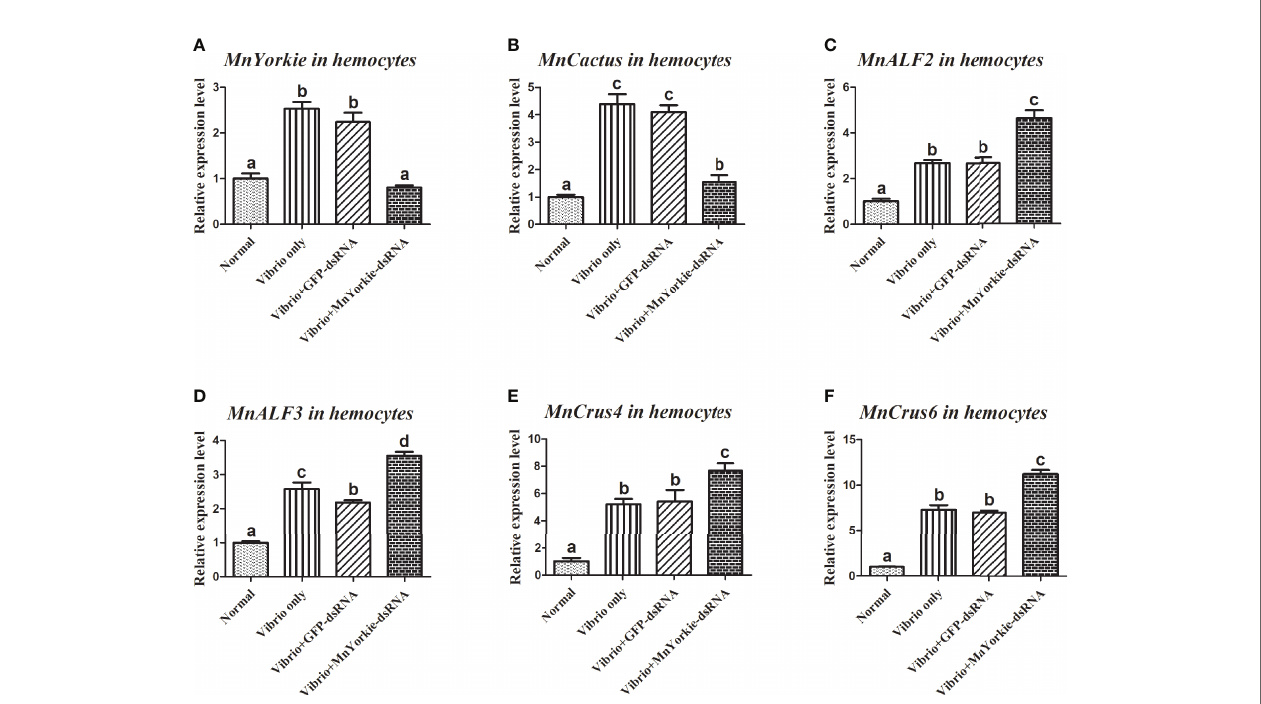
FIGURE 9 | Analysis of MnCactus and four immune-related genes expression levels after MnYorkie RNAi. (A) Ef fi ciency of RNAi detected by RT-qPCR in hemocytes at 36 h post of MnYorkie -dsRNA and V. parahaemolyticus injection. The mRNA expression levels of MnCactus (B) , MnALF2 (C) , MnALF3 (D) , MnCrus4 (E) , MnCrus6 (F) were detected by RT-qPCR at 24 h injection of V. parahaemolyticus post MnYorkie RNAi. Signi fi cance differences were compared between the normal group to other treated groups at the same time point. Signi fi cant differences were marked with different letters (a, b, c, d).